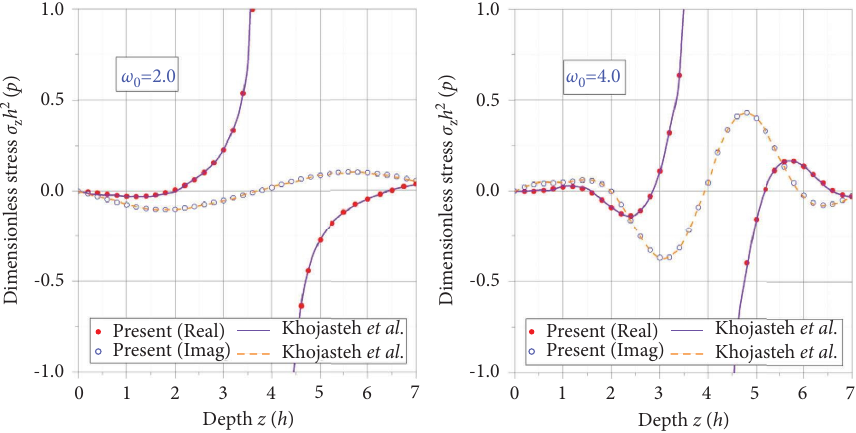
Figure 5: Te real and imaginary parts of the dimensionless vertical stress at origin versus the dimensionless